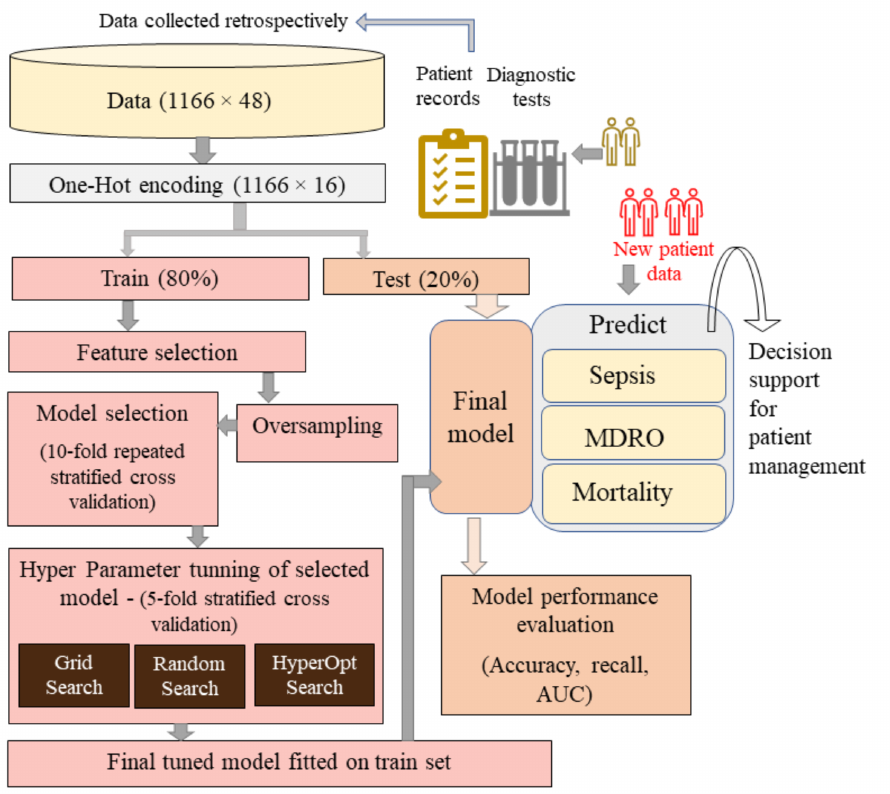
Figure 1. Schematic representation of the adopted methodology for building predictive models. The model is trained using 80% of the available data and tested using the rest of the held-out data (unseen by the model during training). When new patient data are available, the final model in the hospital decision support can be used for the prediction of sepsis, MDRO, and mortality for efficient patient